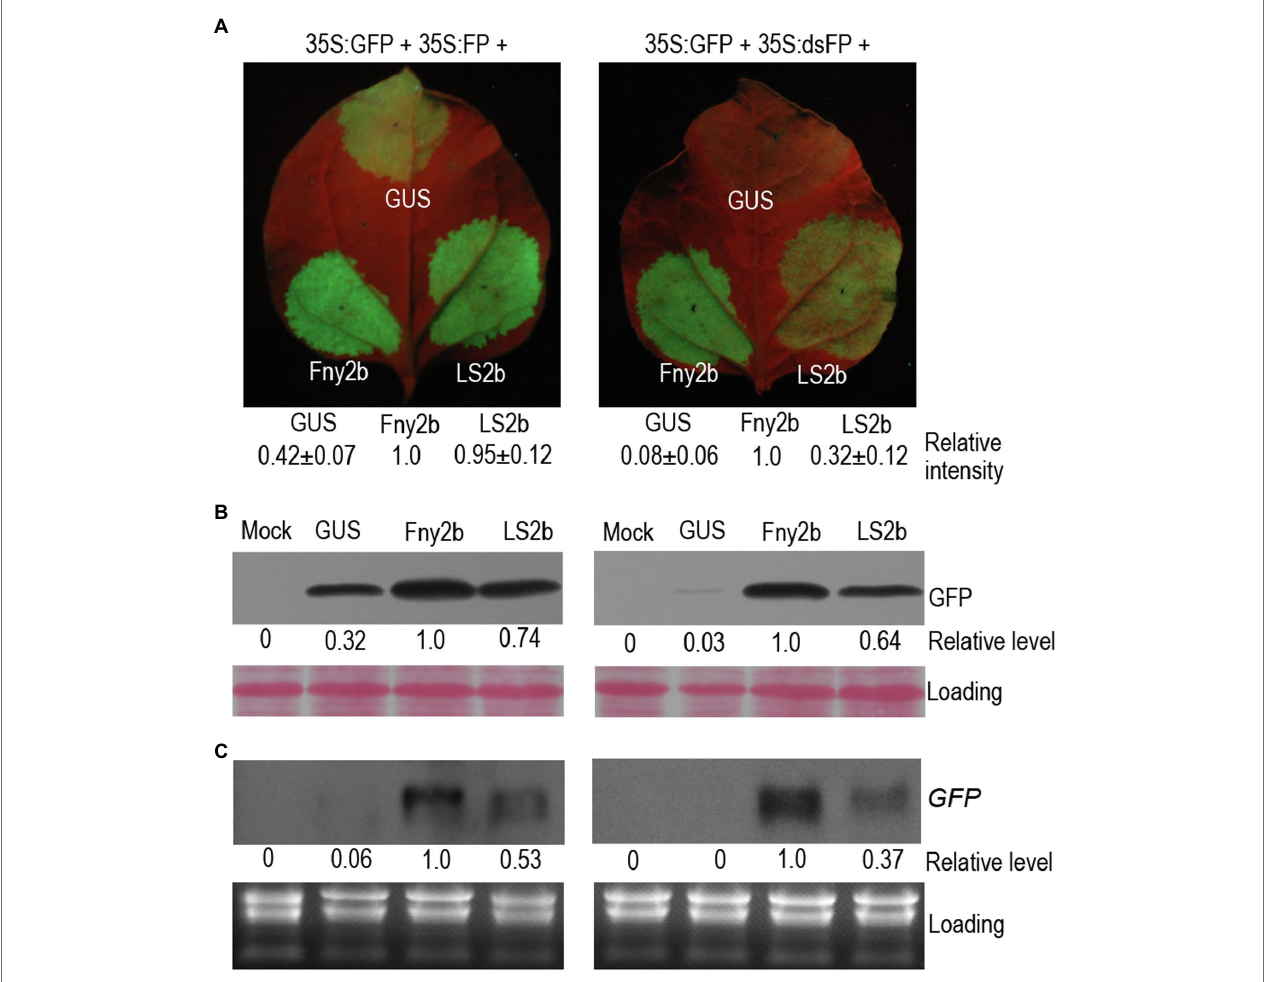
FIGURE 1 | Differences in RNA silencing suppressor activity of Fny2b and LS2b in inhibition of local GFP silencing. (A) Observation of GFP fluorescence. Patches on the 6th true leaves of Nicotiana benthamiana plants were infiltrated with cells of Agrobacterium tumefaciens carrying a GFP reporter construct (35S:GFP), together with cells carrying either a construct to express an aberrant GFP -derived sense RNA (35S:FP; Left Panel) or a construct expressing a GFP -derived inverted repeat RNA (35S,dsFP; Right Panel). Co-infiltrations of these mixtures with cells carrying constructs expressing GUS (control), Fny2b, or LS2b were carried out at the positions indicated on the leaves. Agroinfiltrated leaves were photographed under UV light at 5 days post-infiltration (dpi) (A) . GFP fluorescence intensity of each patch was quantified using ImageJ, and relative intensities were shown at bottom. The relative intensity of Fny2b was defined 1 in both agroinfiltration assays. (B) Immunoblot analyses of the accumulation of GFP protein in the leaf patches indicated in (A) . Total proteins were extracted at 5 dpi and immunoblots probed using a polyclonal anti-GFP serum. Ponceau S staining was used to confirm that equal amount of protein were loaded in each gel lane. (C) Northern blot analyses of the steady-state accumulation of GFP transcripts. GFP transcripts were detected using a DIG-labeled DNA probe. Ribosomal RNAs stained by ethidium bromide were used as loading controls. ‘Mock’ samples were extracted from leaf tissue infiltrated with infiltration buffer. Relative level of GFP protein (B) or GFP transcript (C) were quantified using Image J and shown at bottom. The relative level of Fny2b was defined 1 in both